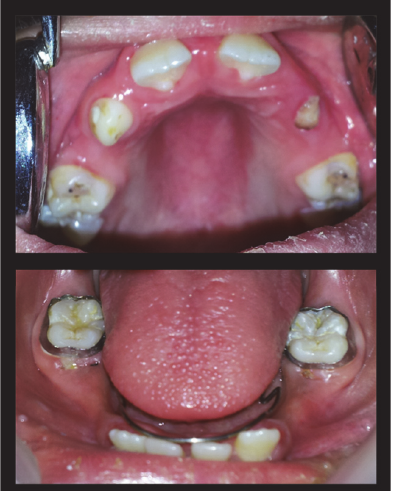
Figure 5: Posttreatment view with restored caries and placement of space maintainer in lower arch.